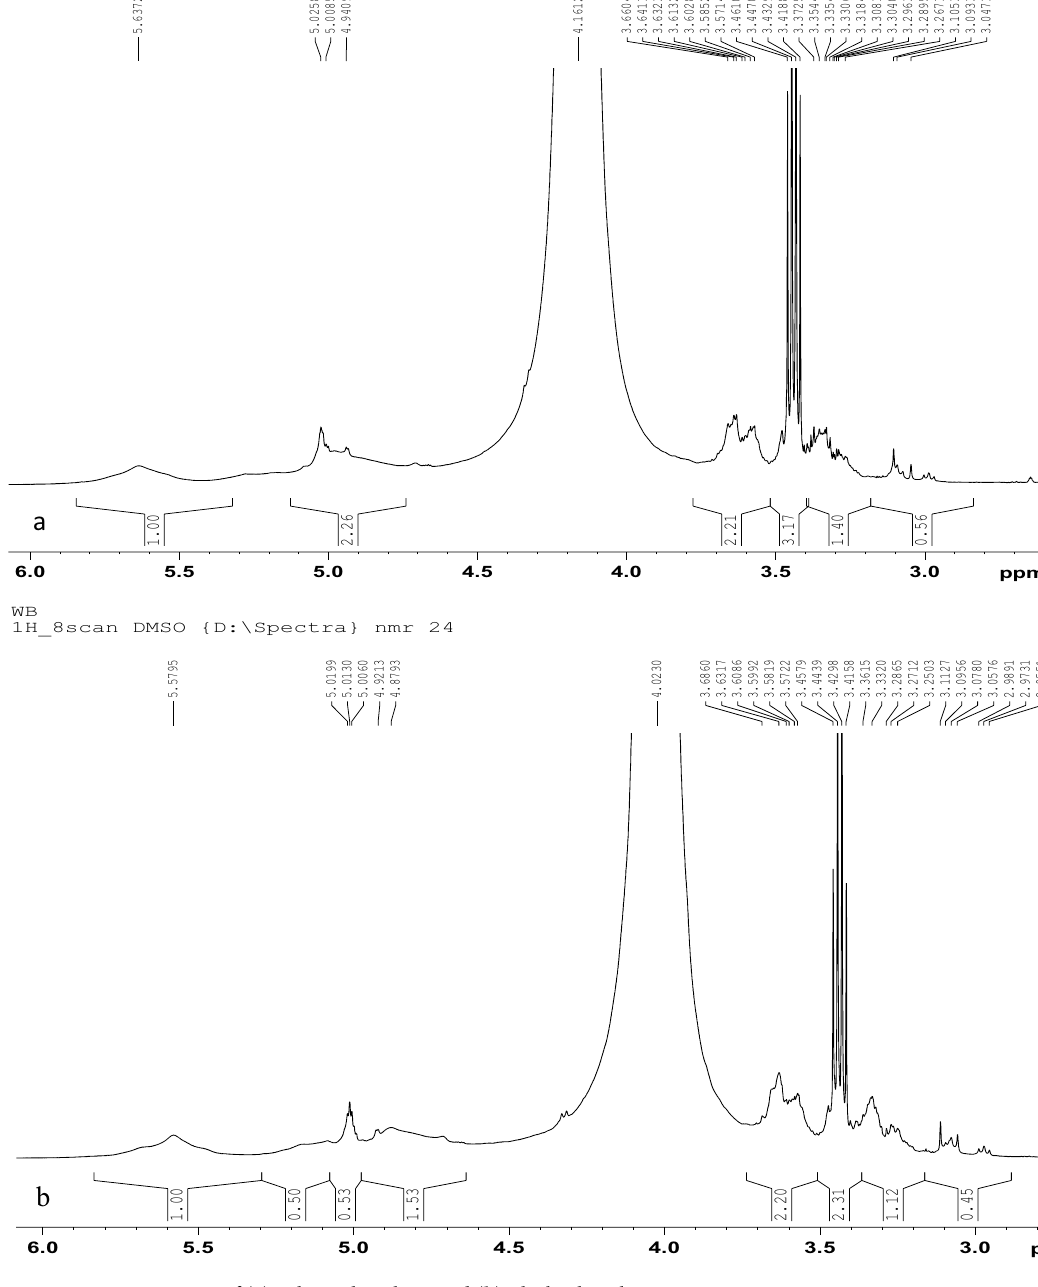
Figure 5. NMR of ( a ) White wheat beer and ( b ) Black wheat